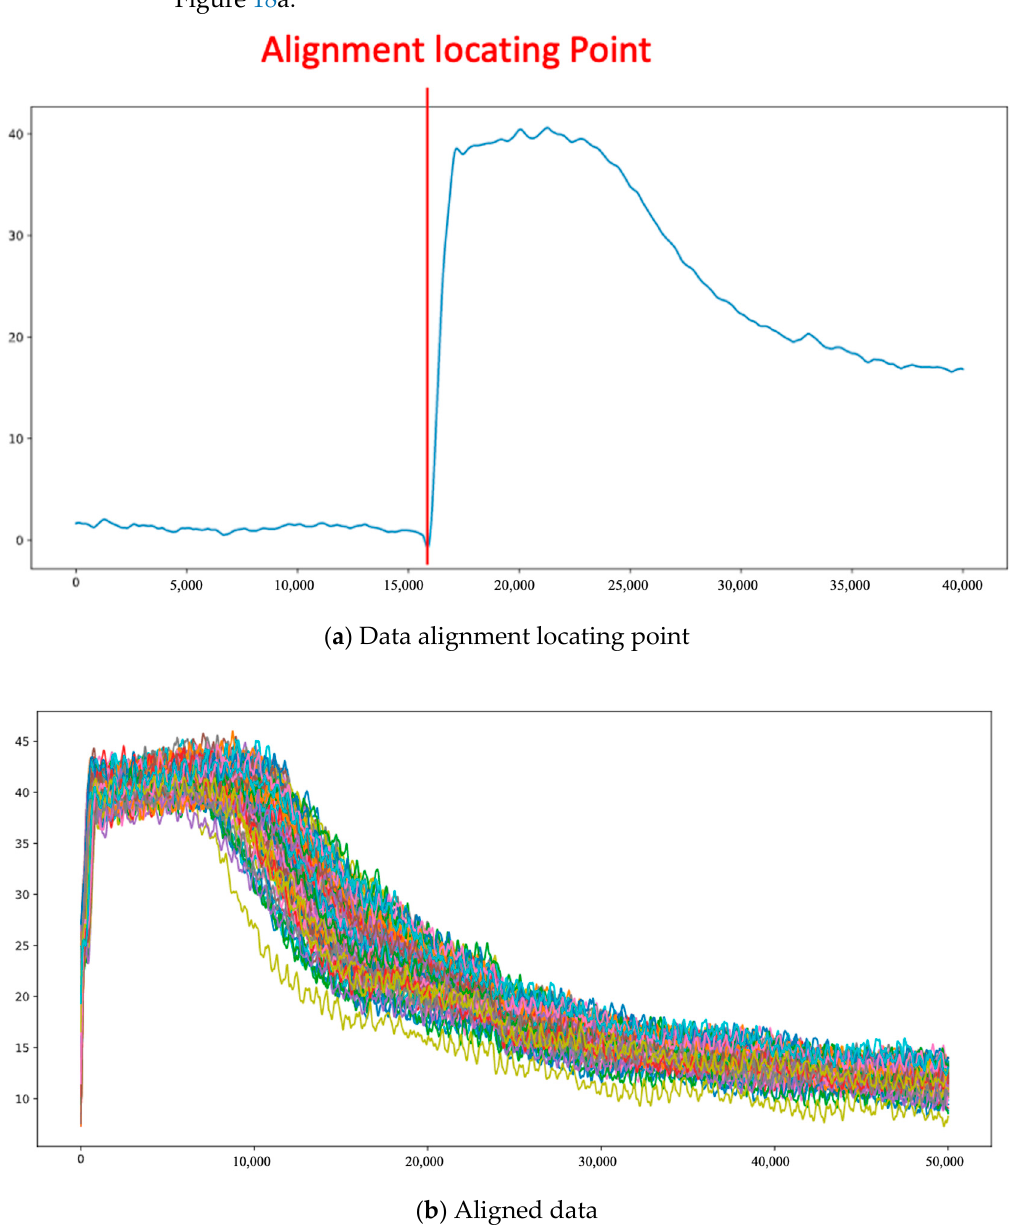
Figure 18. Data alignment by first-order difference.